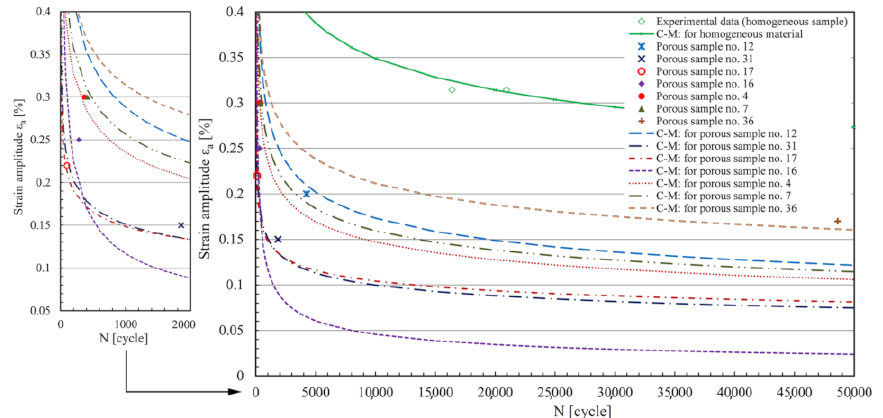
Figure 14. Display of the calculated shift of the C–M curves for all porous samples